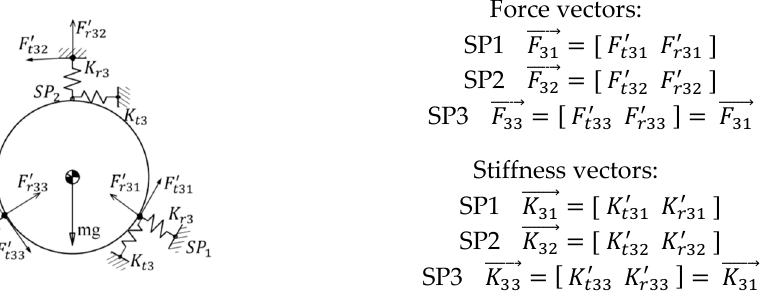
Figure 7. Flowchart of the optimization of the stiffness vector.